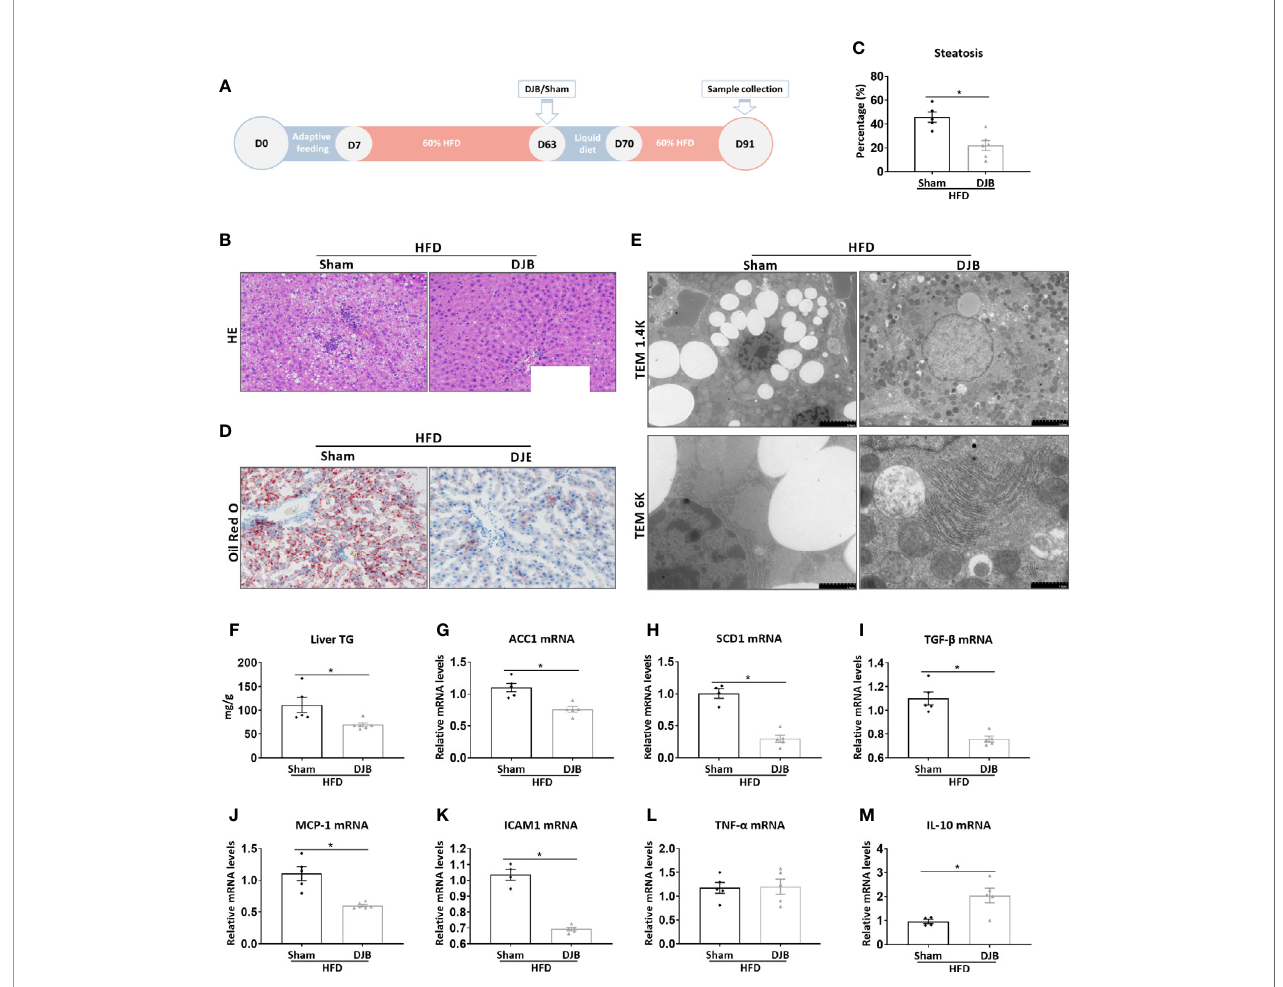
FIGURE 1 | Effects of DJB on hepatic steatosis in HFD-fed rats. (A) Experimental design: Male SD rats were fed with a 60% HFD to induce liver injury. At 8 weeks after HFD feeding, the rats were subjected to either DJB or sham operation. HFD was resumed 1 week after the surgery for 3 more weeks. The effect of DJB on hepatic steatosis was evaluated at 4 weeks after surgery. (B) Representative photomicrographs of liver histology from an HFD-fed DJB-operated rat (HFD-DJB) and an HFD-fed sham-operated rat (HFD-Sham). Original magni fi cation, x200. (C) the percentage of steatotic hepatocytes in HFD-DJB and HFD-Sham rats. Original magni fi cation, x200. (D) Representative photomicrographs of Oil Red O staining from a HFD-DJB rat and a HFD-Sham rat. Original magni fi cation, x200. (E) Representative images of electron microscopy from a HFD-DJB rat and a HFD-Sham rat. (F) Liver triglyceride content in HFD-DJB and HFD-Sham rats. Hepatic mRNA expression of ACC1 (G) , SCD1 (H) , TGF ‐ b (I) , MCP-1 (J) , ICAM1 (K) , TNF- a (L) , and IL-10 (M) in HFD-DJB and HFD-Sham rats. Results are expressed as mean ± SE (HFD-Sham, n=5; HFD-DJB, n=6) and compared by Student ’ s t-test; *P<0.05 versus the HFD-Sham group. DJB, Duodenal-jejunal bypass surgery; HFD, High fat diet; NAS, NAFLD activity score; TG, triglycerides; ACC1, Acetyl-CoA carboxylase-1; SCD1, Stearoyl-CoA desaturase-1; TGF ‐ b , Transforming growth factor beta; MCP-1, Monocyte chemotactic protein 1; ICAM1, Intercellular adhesion molecule 1; TNF- a , Tumor necrosis factor alpha; IL-10,